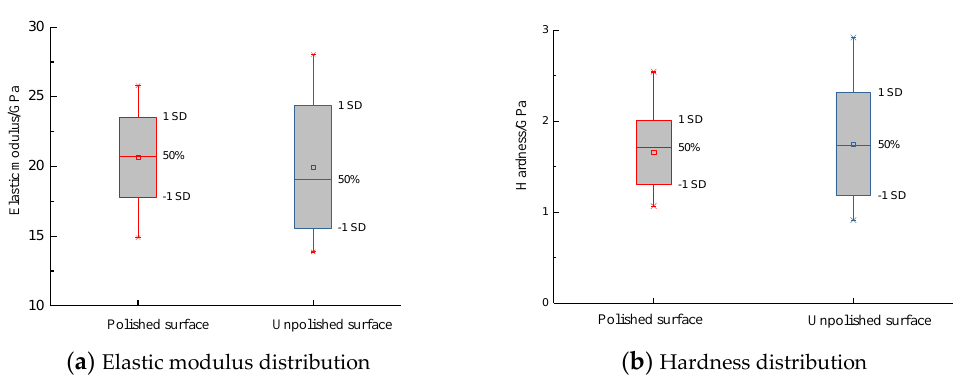
Figure 9. Shale surface roughness.